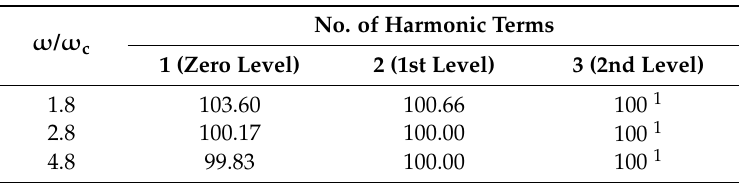
Table 4. Harmonic term convergence study (number of structural modes = 2, number of acoustic modes = 4, l = 5 a , γ =